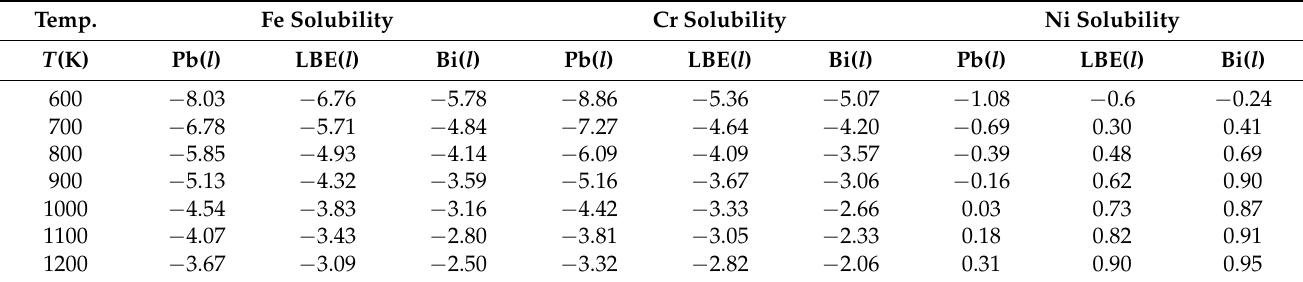
Table 4. Solubility {log 10 S (wt%)} of Fe and Cr in liquid Pb, LBE and Bi.